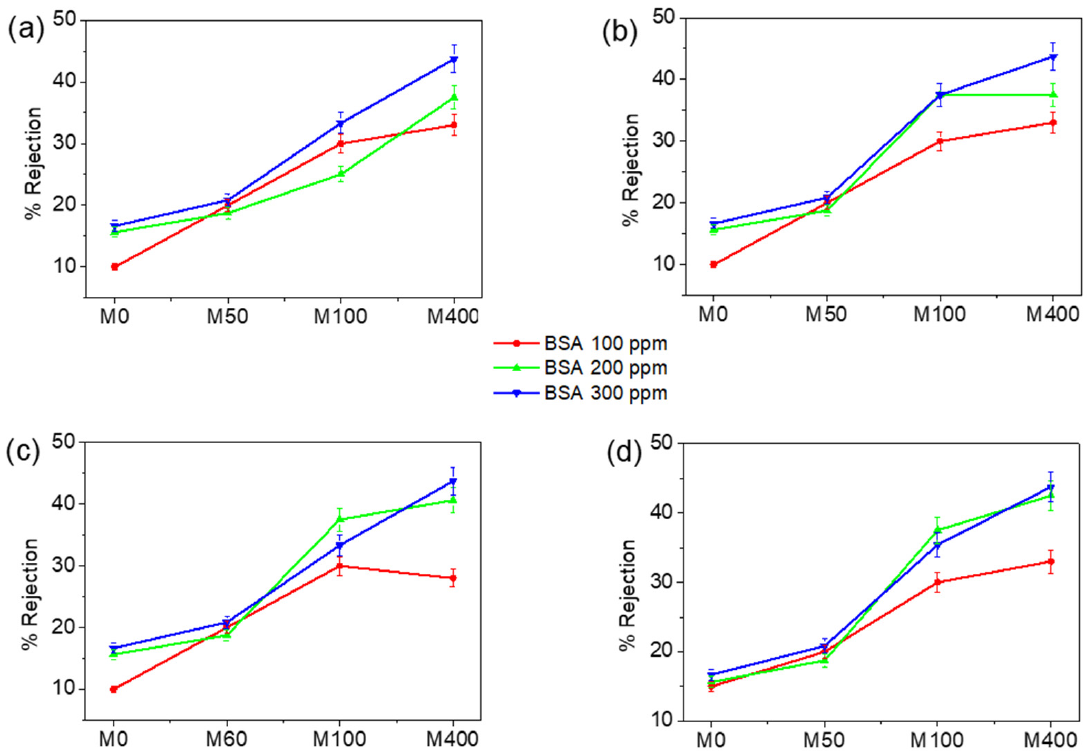
Figure 8. Rejection of nanocomposite membranes of ( a ) 0.05, ( b ) 0.06, ( c ) 0.07, and ( d ) 0.08 mm thickness in a crossflow filtration system at 2 bar pressure.